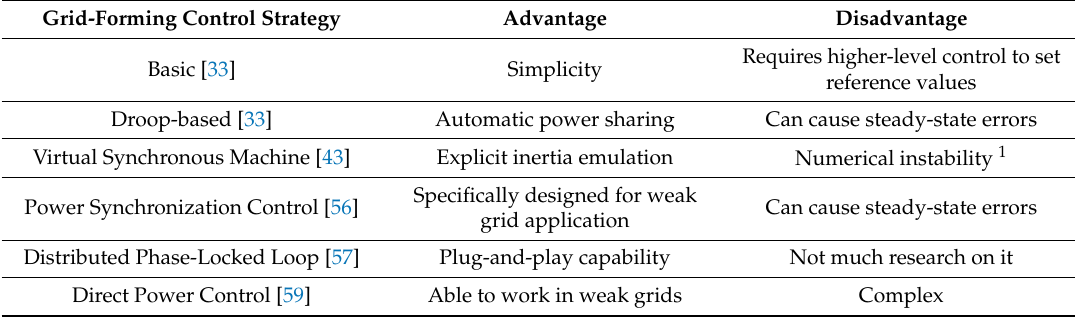
Table 3. Comparison of grid forming control strategies to achieve o ff shore wind farm black